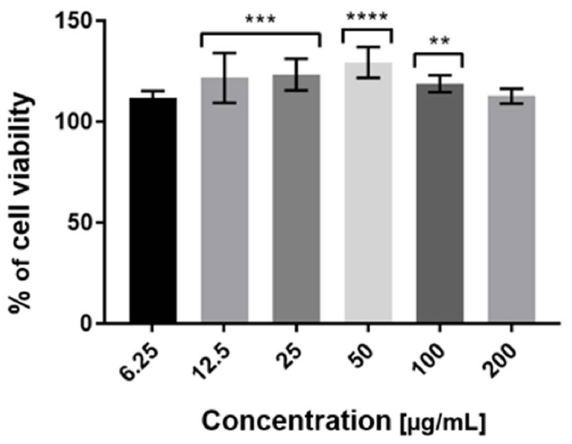
Figure 5. The reduction of resazurin after 24 h exposure to the aqueous MAE Schisandra chinensis extracts (6.75, 12.5, 25, 50, 100, 200 µ g/mL) in cultured keratinocytes. Data are the mean ± SD of three independent experiments, each of which consists of three replicates per treatment group. ** p < 0.01, *** p < 0.001, **** p < 0.0001 versus the control (100%).